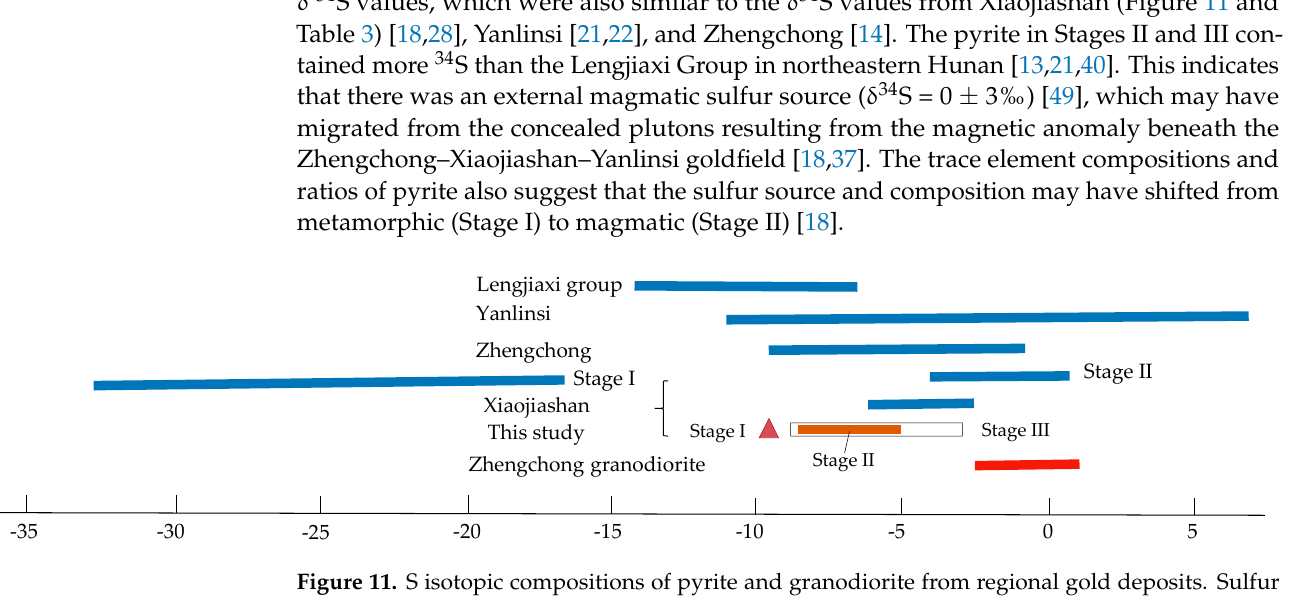
Figure 11. S isotopic compositions of pyrite and granodiorite from regional gold deposits. Sulfur isotope data of the Lengjiaxi Group [13,21,40], Yanlinsi [21,22], Zhengchong [14], Stages I and II